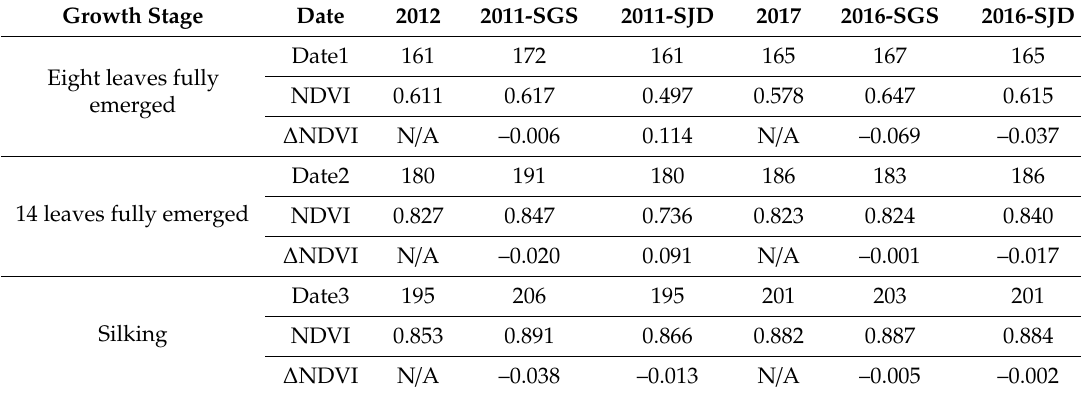
Table 5. Comparisons of 2012 and 2017 corn NDVI changes with their previous years of values based on the same growth stages and the same Julian days in Carroll County. The columns 2011-SGS and 2011-SJD, and 2016-SGS and 2016-SJD illustrate 2011 and 2016 NDVI values based on the same growth stages (SGS) and the same Julian days (SJD), and 2012 and 2017 NDVIs’ deviations from 2011 and 2016 correspondingly. Date1, 2, 3 are all in Julian